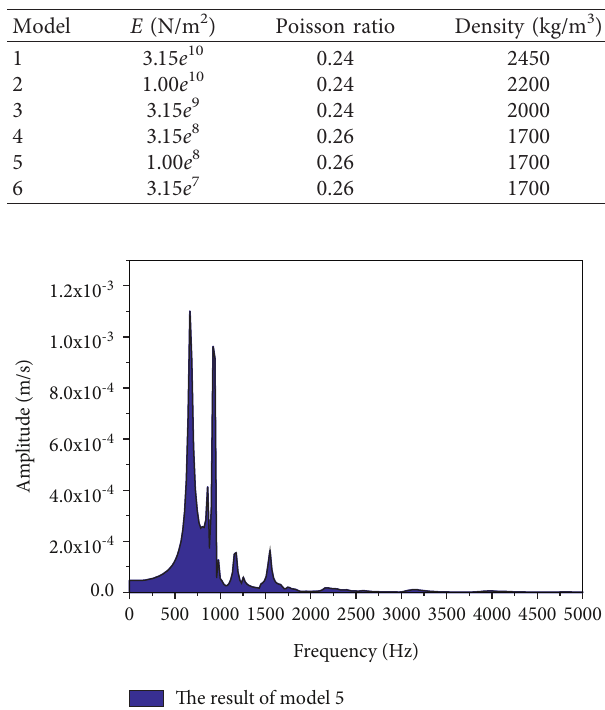
Figure 15: Calculation model of concrete floating layer. Table 4: Calculation conditions of material parameters of concrete floating layer.